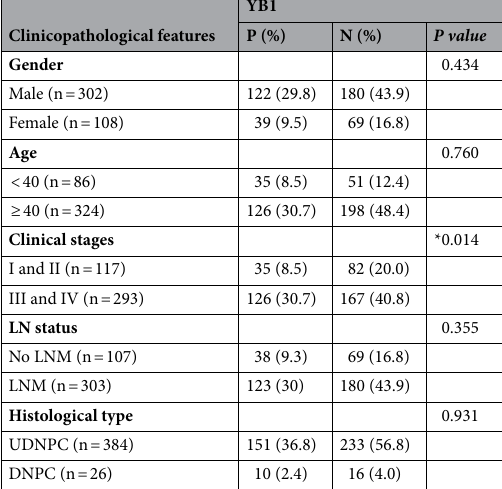
Table 2. Analysis of association between expression of YB1 protein and clinicopathological features of NPC. DNPC differentiated non-keratinized nasopharyngeal carcinoma, UDNPC undifferentiated non-keratinized